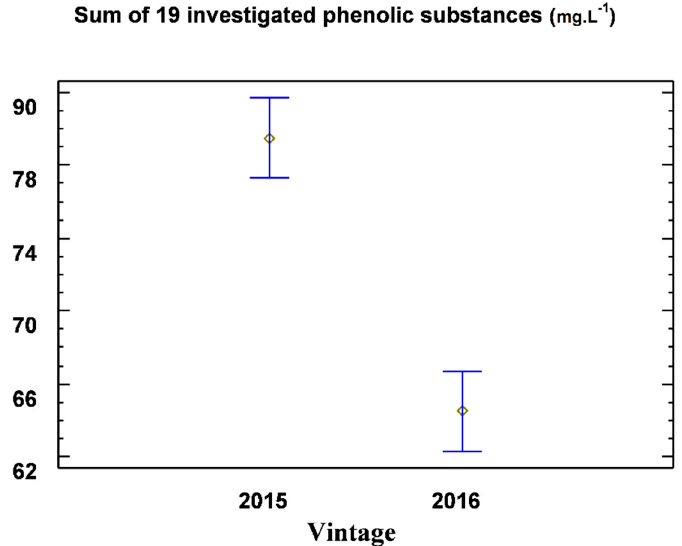
Figure 3. Graphic representation of the 95% confidence intervals of the content of 19 monitored phenolic